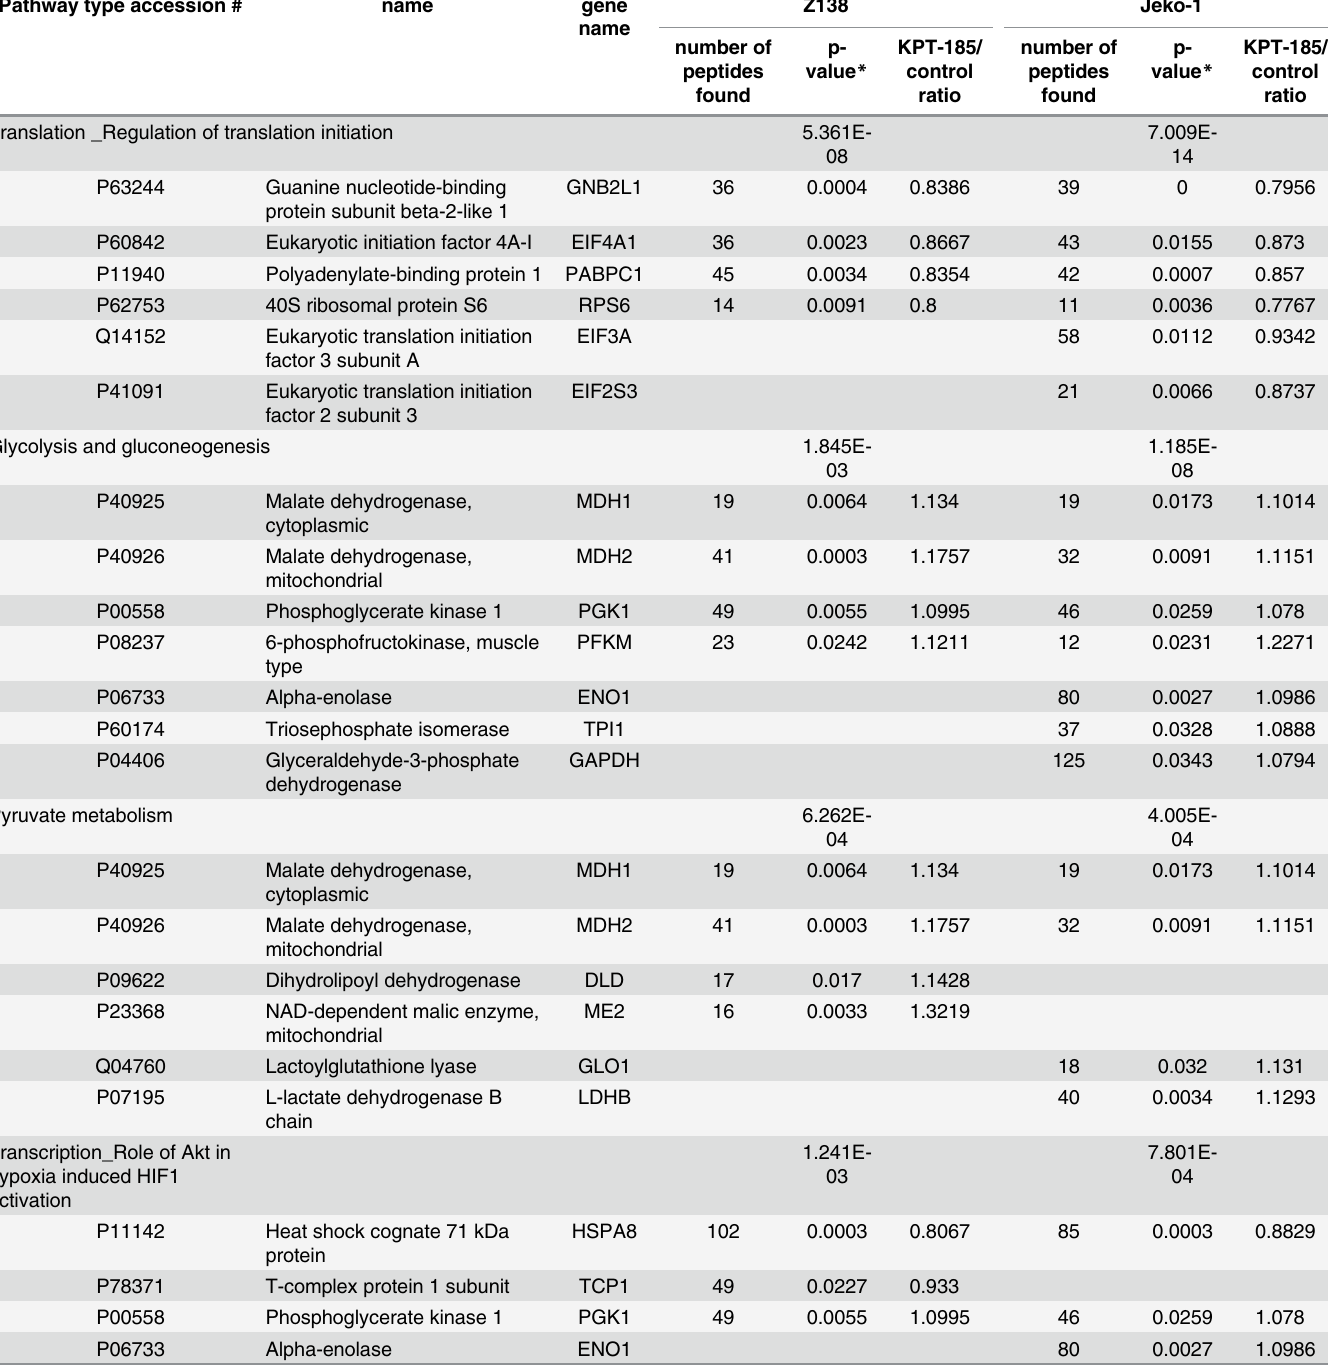
Table 3. Consistent pathway alteration in Z138 and Jeko-1 cells after KPT185 treatment.